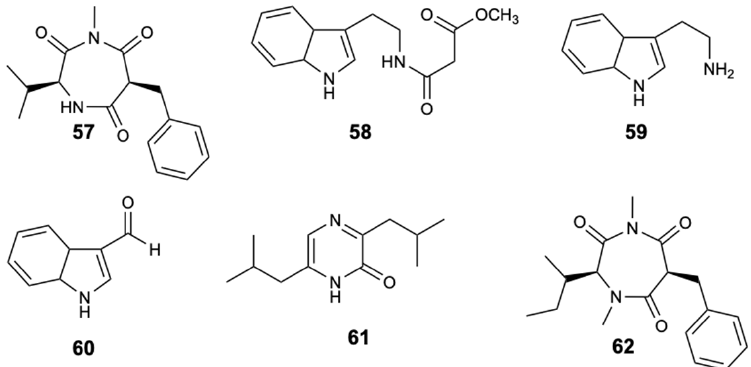
Figure 16. Structures of compounds 57 – 62 .